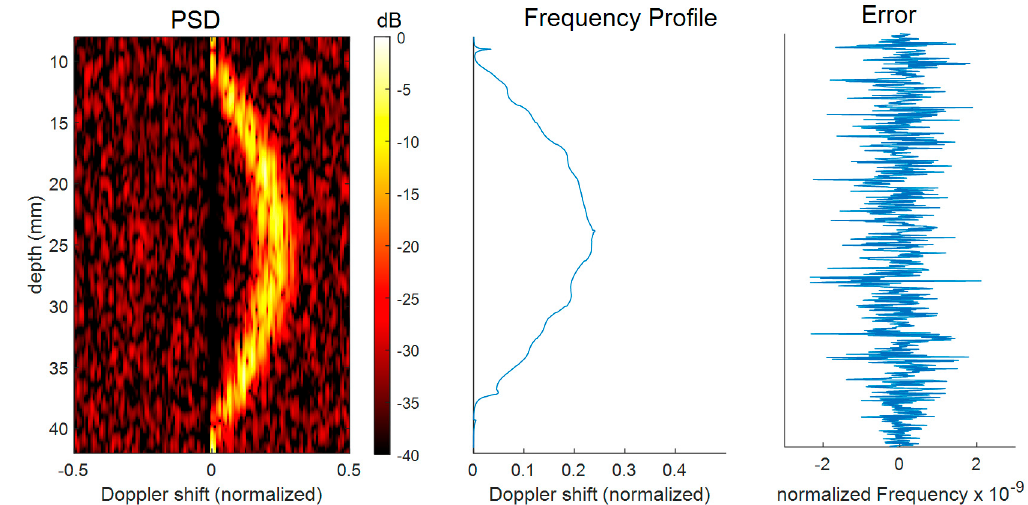
Figure 8. A 0.5 m / s flow was investigated with a focused transducer transmitting short 6 MHz frequency bursts. An example of power spectral density (PSD) matrix (left), frequency profile (center) and its error (right), calculated in the FPGA are